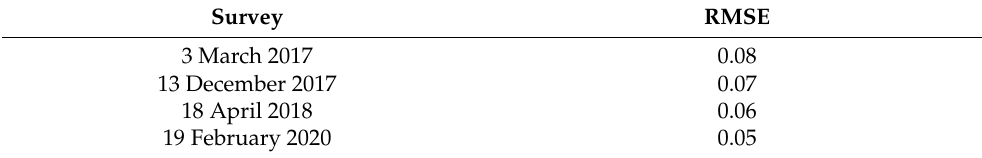
Table 2. RMSE of elevation data for each survey resulting from the validation process.